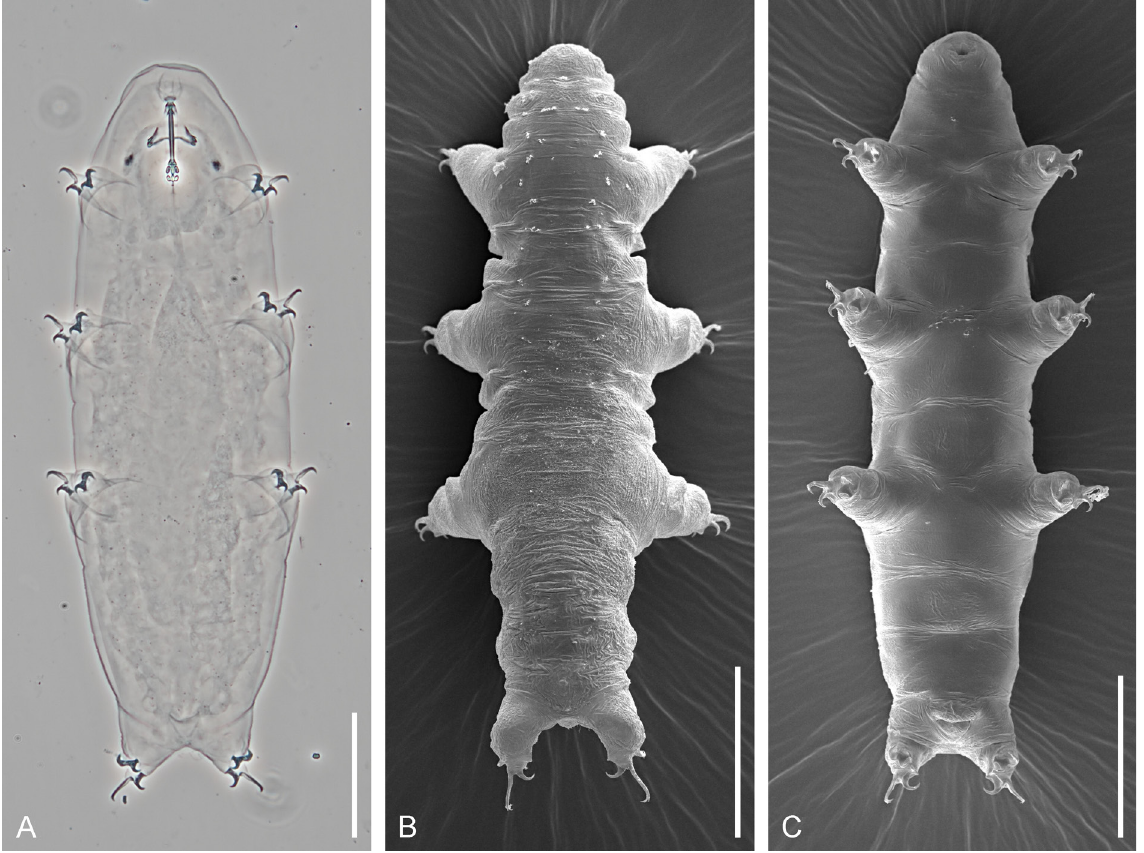
Fig. 1. Hypsibius pallidoides Pilato, Kiosya, Lisi, Inshina & Biserov, 2011, total view. A . Phase contrast (SPbu 251(82)). B . Dorsal view in SEm. C . Ventral view in SEm. Scale bars = 50